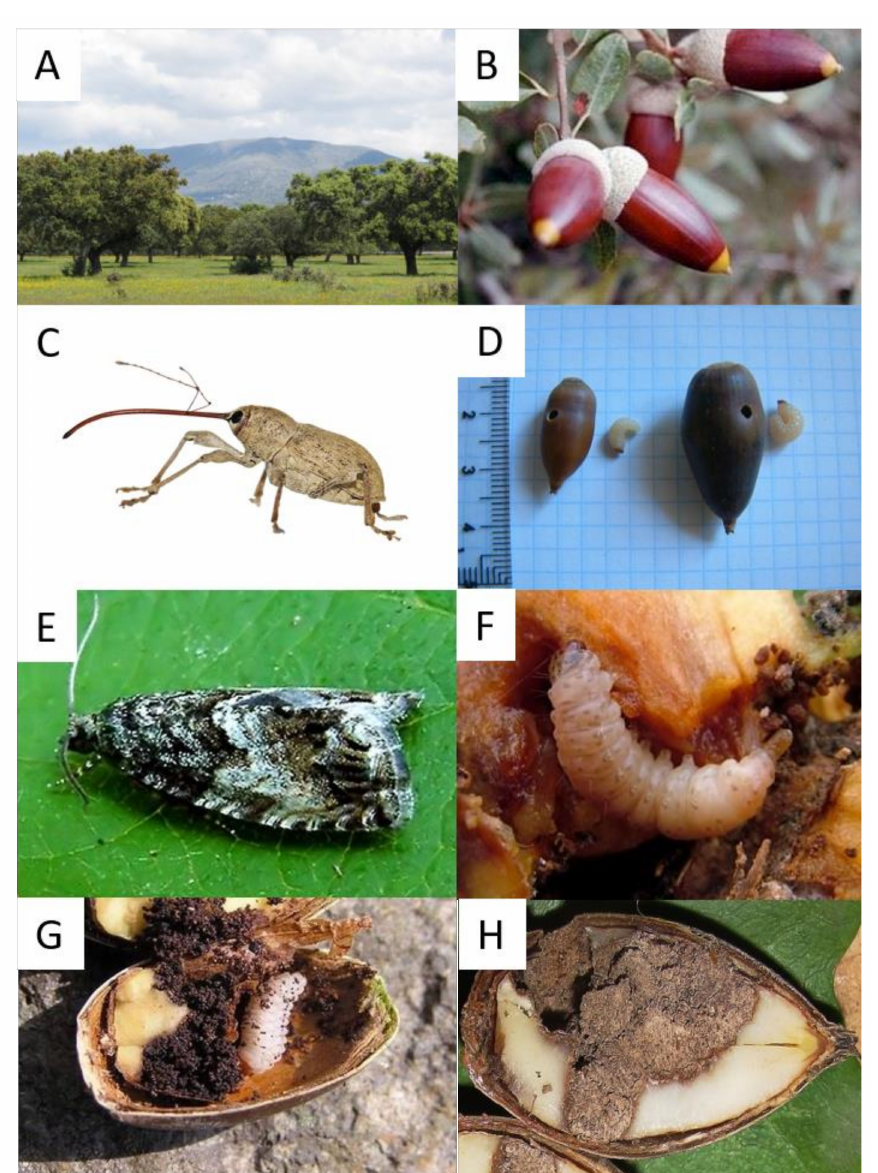
Figure 2. ( A ) One of the study areas with scattered holm oaks Quercus ilex L. ( B ) Acorns of Quercus ilex L. ( C , D ) Curculio elephas adult female and larvae. ( E , F ) Cydia fagiglandana adult and larva. ( I ) Acorn in which cotyledons have been mostly eaten and the embryo (located at the pointed end) has been predated. ( H ) Acorn with cotyledons only partially consumed in which the embryo has not been